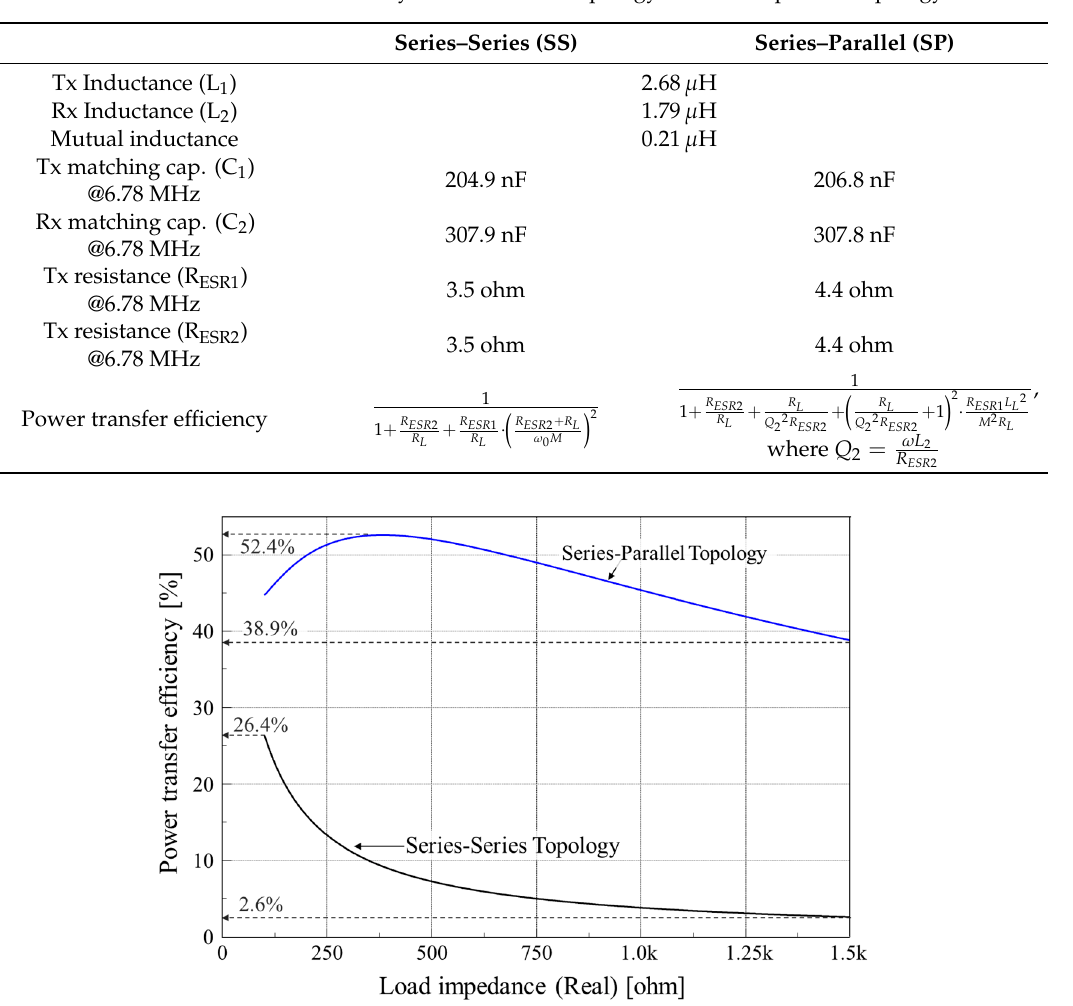
Table 1. Power transfer efficiency of series–series topology and series–parallel topology.